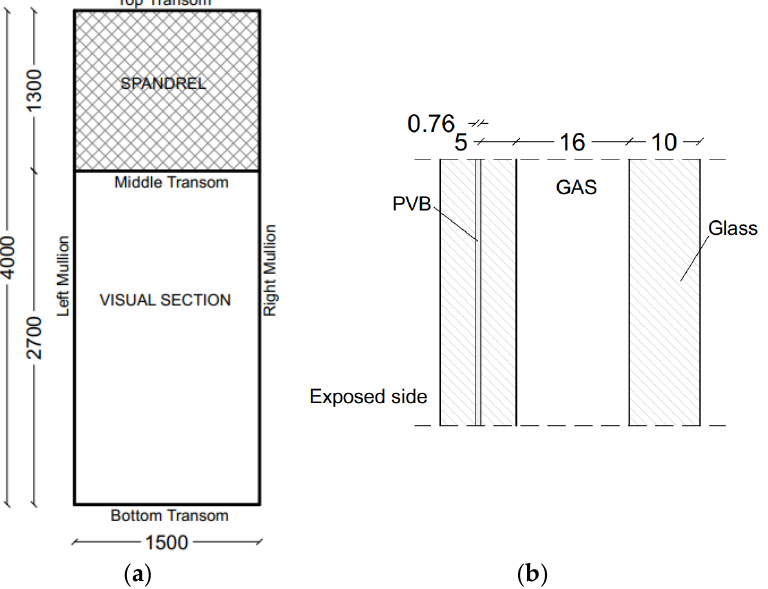
Figure 7. Reference curtain wall specimen: ( a ) layout and ( b ) nominal cross-section of the visual section (dimensions in mm). section (dimensions in